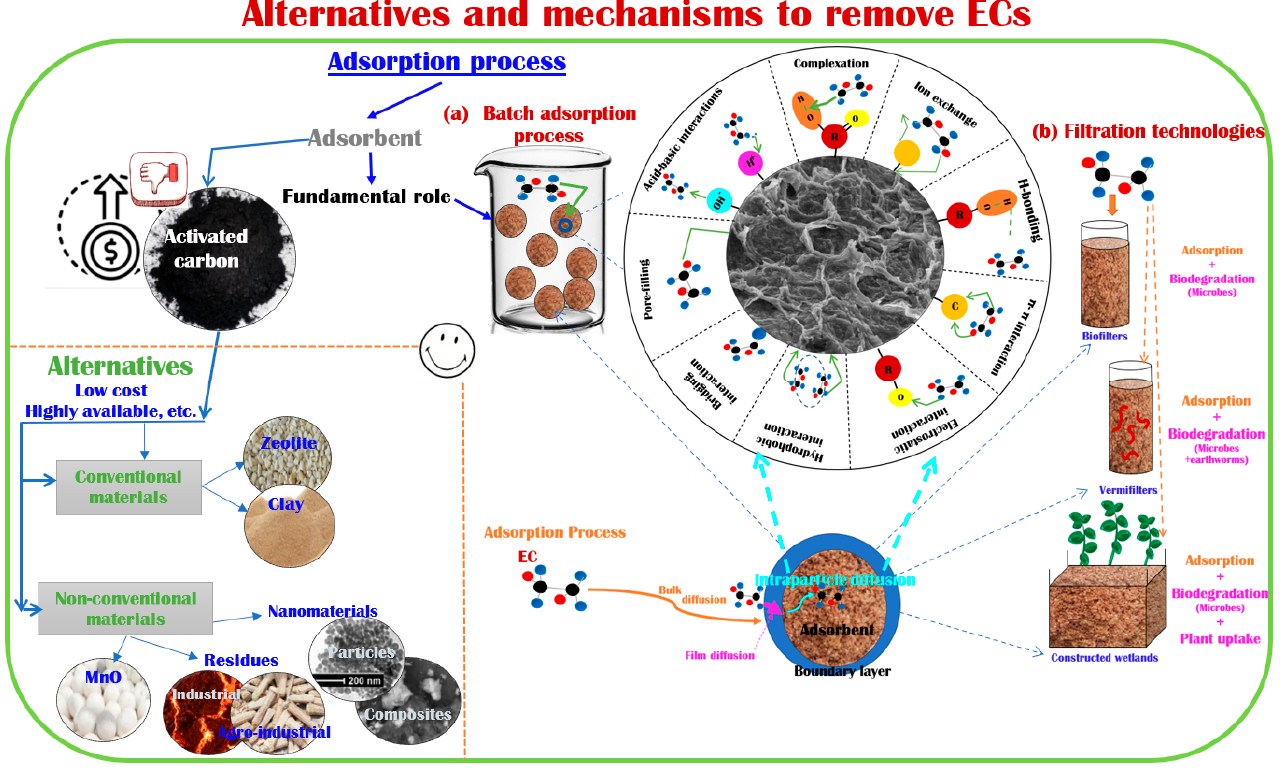
Figure 3. Alternatives and mechanisms to remove ECs in batch and fi ltration technologies.